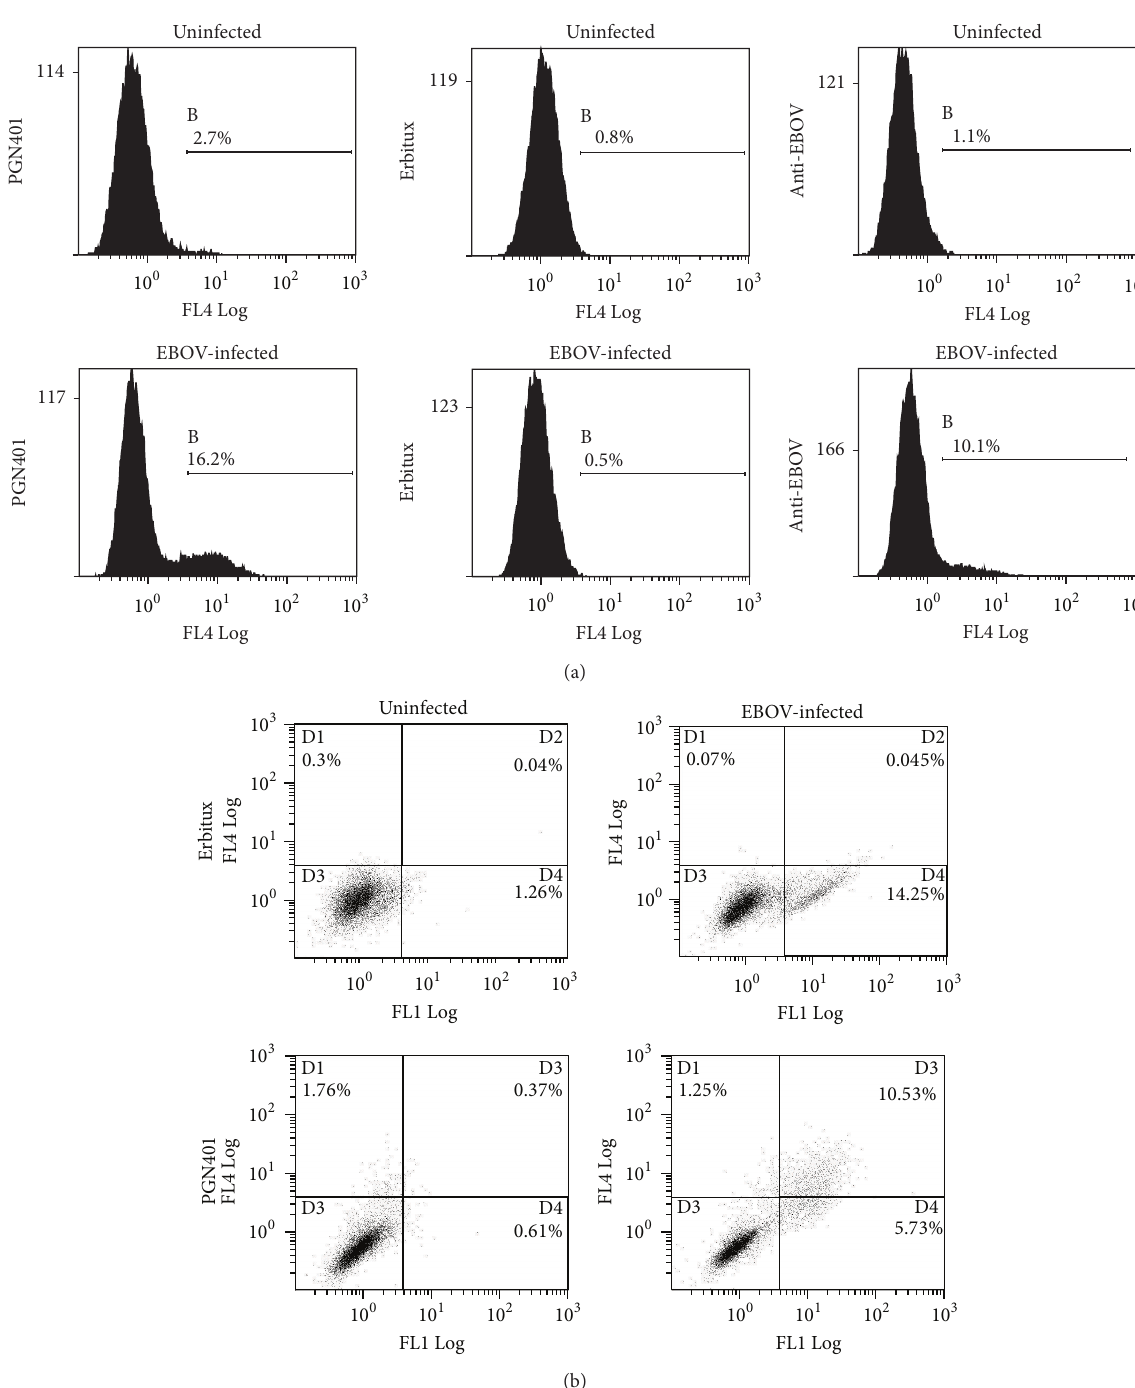
Figure 1: Flow cytometry staining of EBOV-infected cells. (a) Single color staining of cells with anti-EBOV, Erbitux, and PGN401 antibodies. Histograms show frequency of cells versus level of fluorescence intensity. The marker regions quantify the percentage of cells stained above background levels. (b) Dual color labeling with anti-EBOV and PGN401 antibodies. The 𝑥 -axis relates to the detection of the FL1 channel that detects Alexa-Fluor 488 staining (anti-mouse detector for EBOV antibody) and the 𝑦 -axis, the FL4 channel that detects Alexa Fluor 647 staining (anti-human detector for PGN401 and Erbitux). Quadplots identify the percentage of cells within each